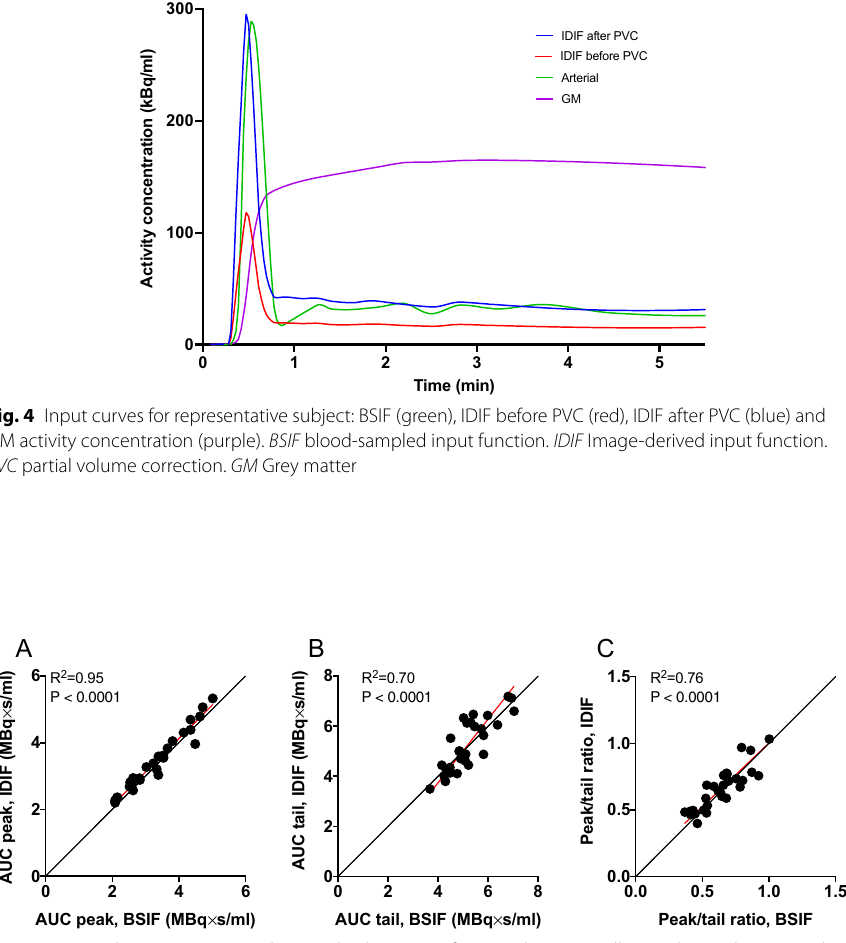
Fig. 5 Scatter plots comparing peak ( A ) and tail ( B ) AUC of BSIF and IDIF, as well as peak-to-tail ratio ( C ). The black lines are lines of identity and the red lines are orthogonal